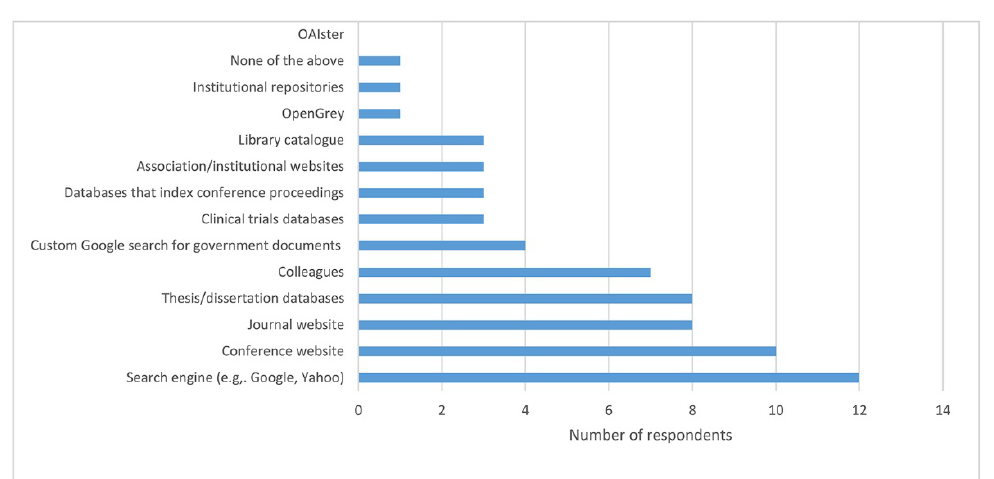
Figure 5 Resources for searching grey